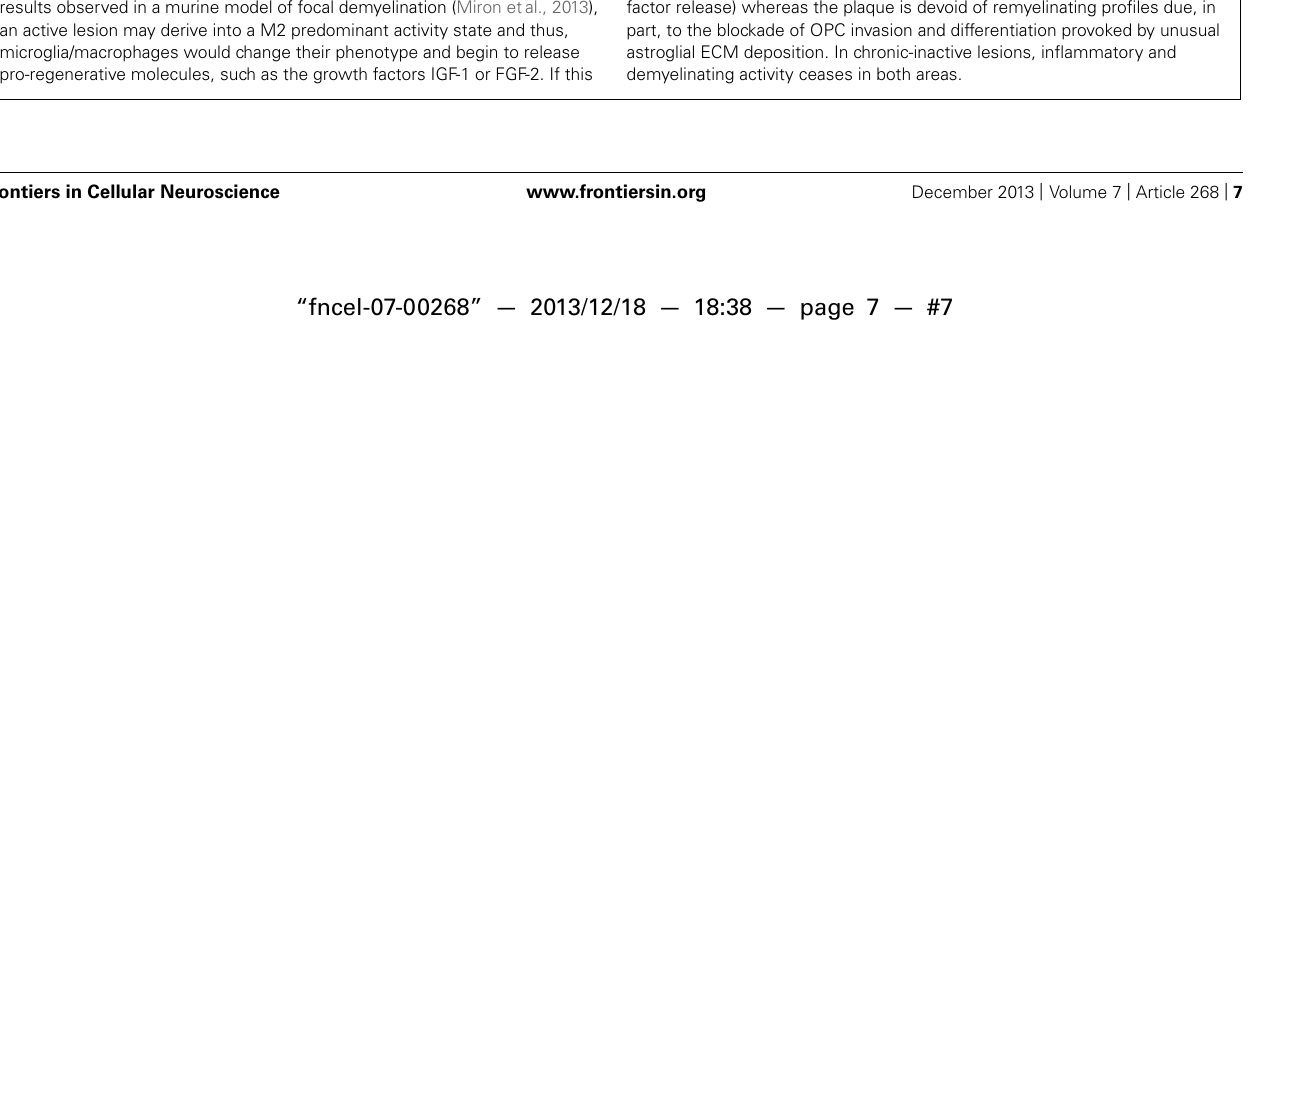
activity persists, partial remyelination may exist in the so-called shadow plaque. By contrast, if the myelin-destructing environment takes hold, an active lesion may evolve into a chronic-active lesion in which remyelination can mainly occur in the periplaque (with M2 microglia/macrophage growth factor release) whereas the plaque is devoid of remyelinating profiles due, in part, to the blockade of OPC invasion and differentiation provoked by unusual astroglial ECM deposition. In chronic-inactive lesions, inflammatory and demyelinating activity ceases in both